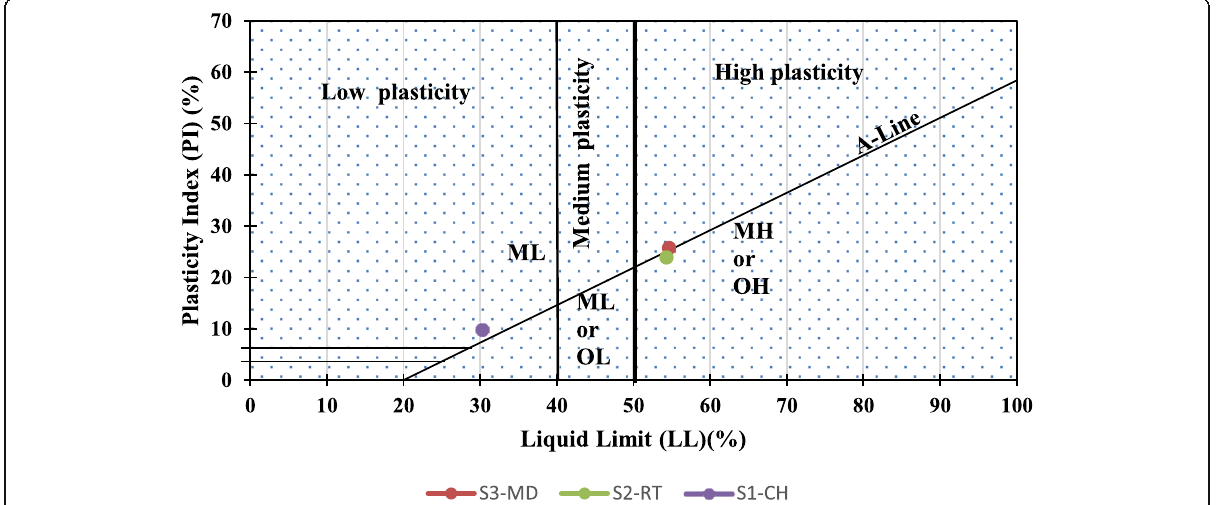
Fig. 8 Plasticity diagram distinguishing the fine-components of the slides ’ soil samples ( − according to EN ISO